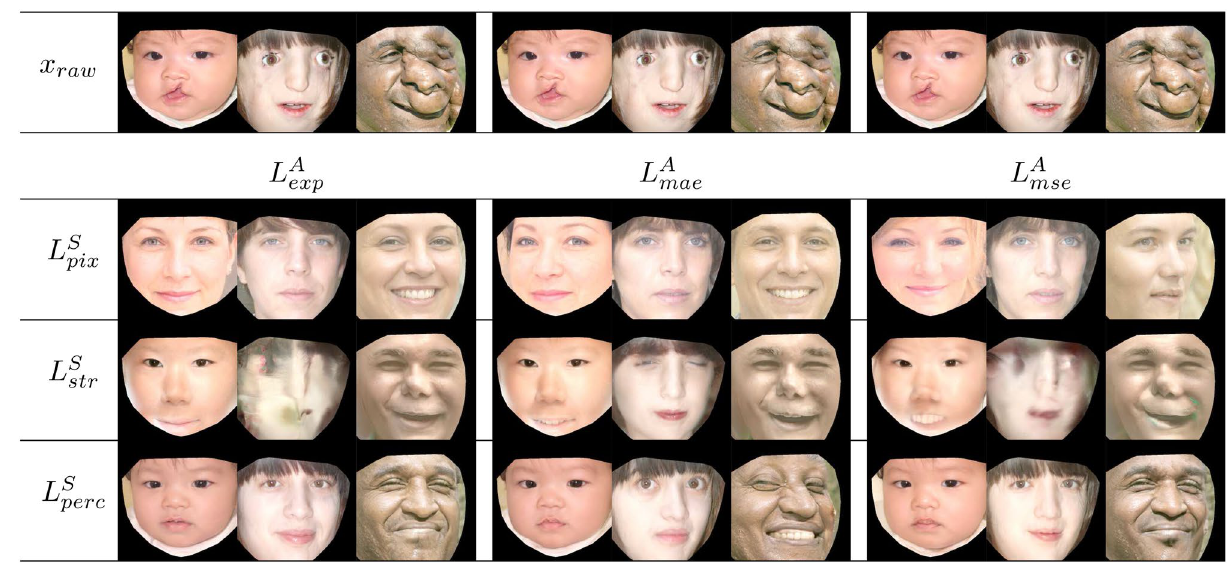
Figure 3. Effects of L S and L A in the normalization procedure. We randomly chose three different raw images in order to run our normalization algorithm to test three different L S and three L A functions. The top row represents the raw images as a reference. The remaining matrix of images below demonstrates the effect of the different similarity ( L S ) and averageness loss ( L A ) tools. By examining this matrix it is visually apparent that the optimal combination of L S and L A derives from the simultaneous use of L S perc and L A mse . The three images depicted in the top row, left to right, correspond to references 40,42,43 , respectively. All remaining images are transformations created by the study